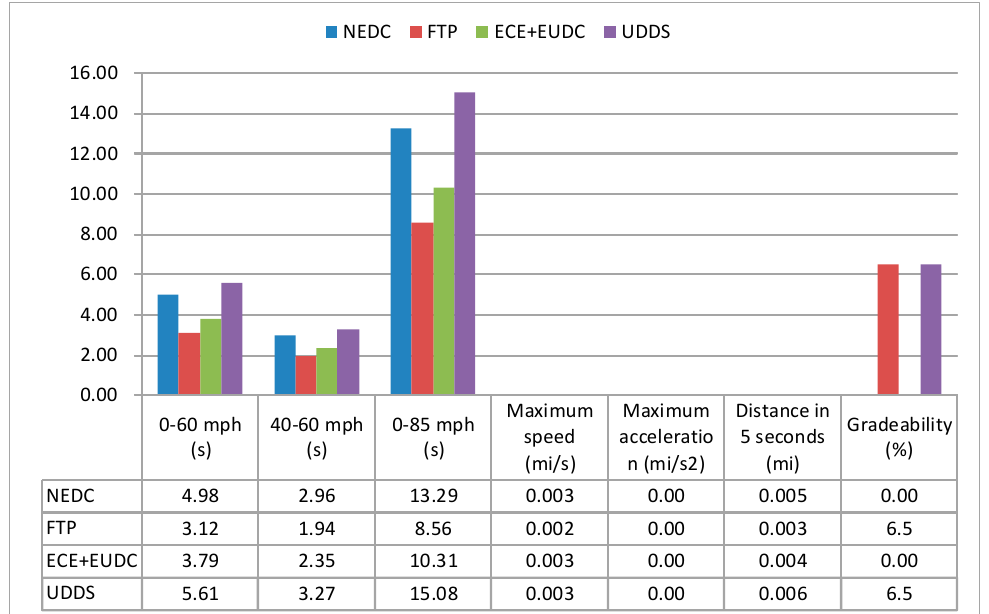
Figure 12. The histogram of the improvements in the dynamic performance between the results using initial and optimal values of the parameters of the control strategy.